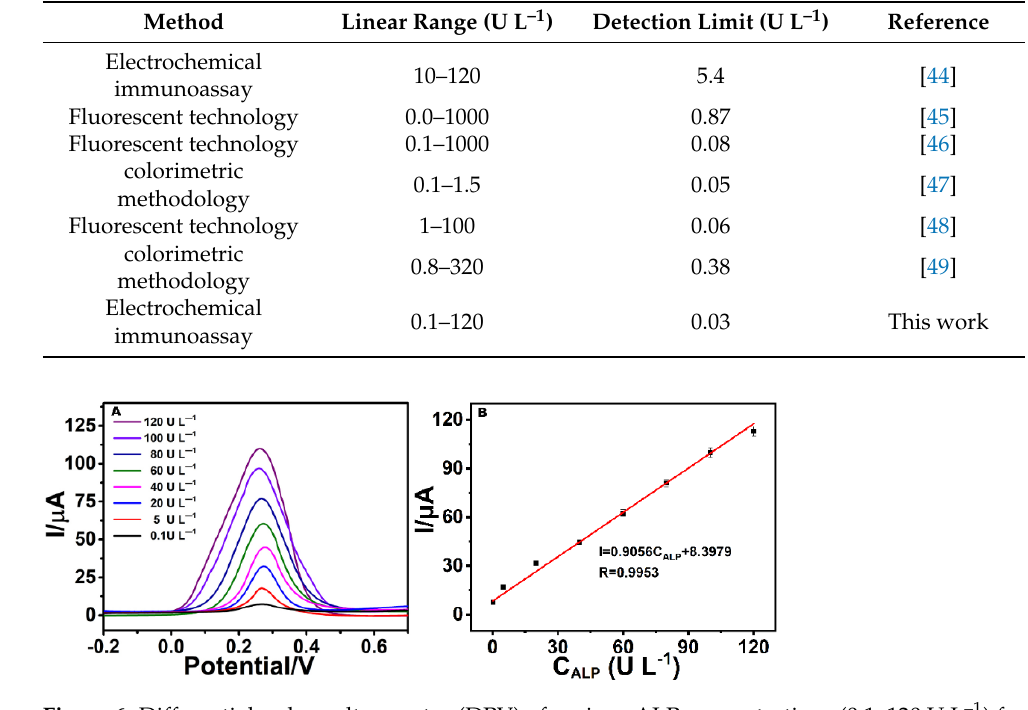
Figure 6. Differential pulse voltammetry (DPV) of various ALP concentrations (0.1–120 U L –1 ) for the AuNP/PEDOT:PSS-modified GCE in 0.01 M PBS (pH 9.0) containing 4 mg mL –1 1-naphthyl phosphate and 1 mM AgNO 3 ( A ). Calibration curves of the immunosensor to various concentrations of ALP ( B ); error bars represent the standard deviation. Table 1. Comparison of the present method with other methods for ALP detection.